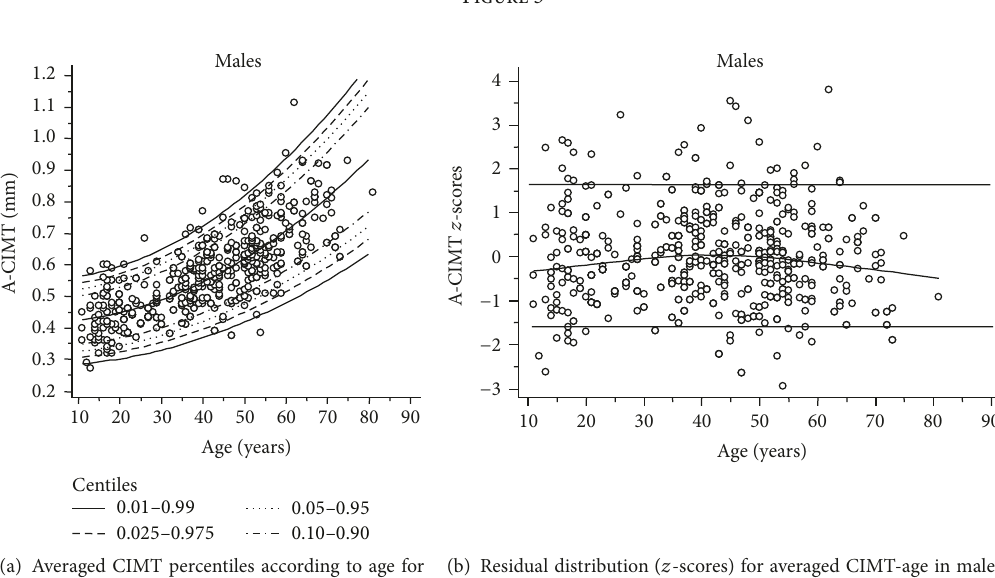
(b) Residual distribution ( 𝑧 -scores) of the averaged CIMT-age analysis (a) Age-specific percentiles of the averaged CIMT for for the entire population. CIMT: carotid intima media thickness the entire population ( 𝑛 = 1 ,012). CIMT: carotid